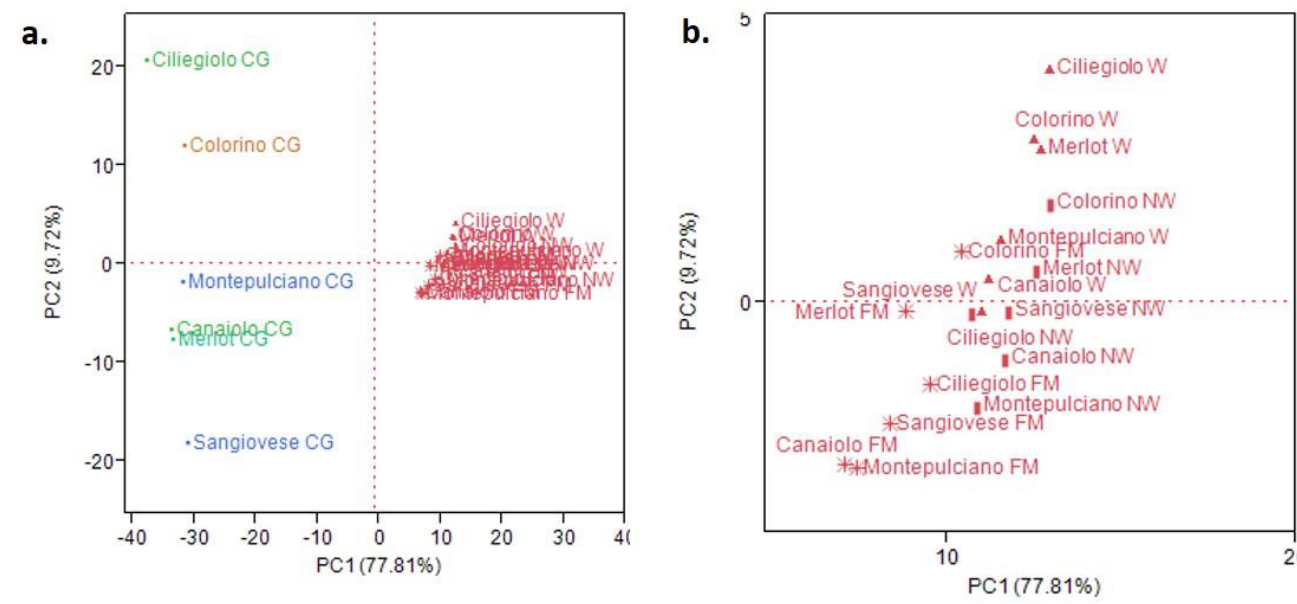
Figure 2. ( a ). Principal component analysis (PCA) plot; ( b ). Magnification of the right quadrants of the